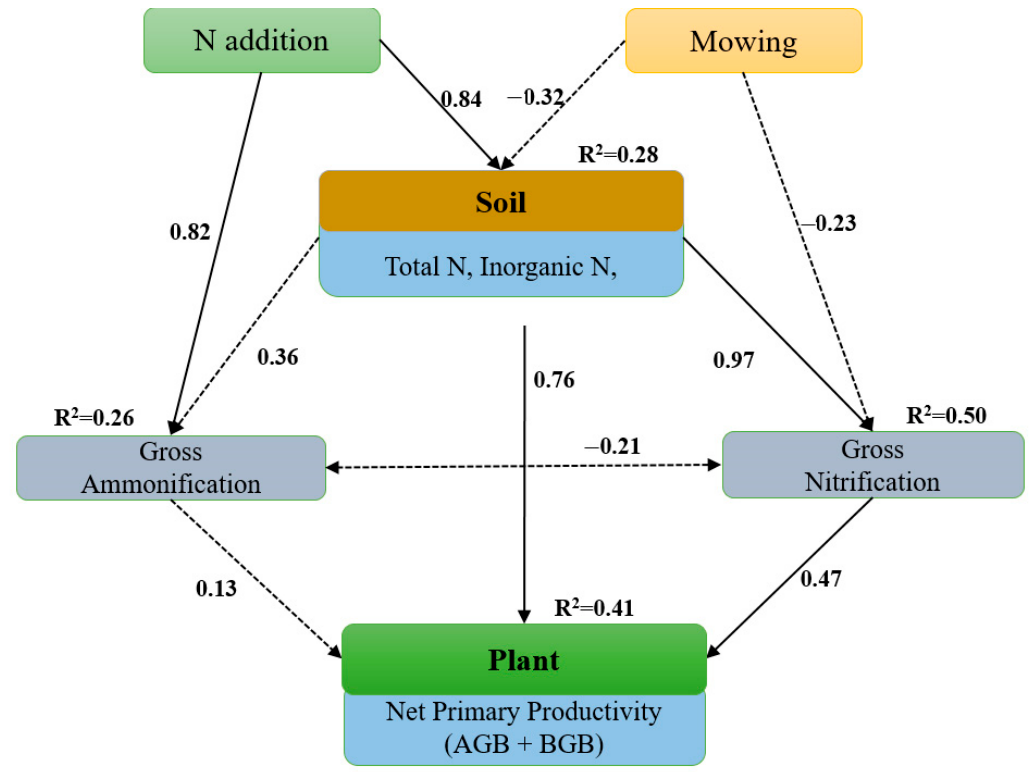
Figure 4. Structural equation model (SEM) analysis of the effects of N addition and mowing on net primary productivity via pathways of soil on gross ammonification rates (GA) and nitrification rates in a temperate steppe in northern China. The bold arrows indicate significant standardized path coefficients ( p < 0.05).